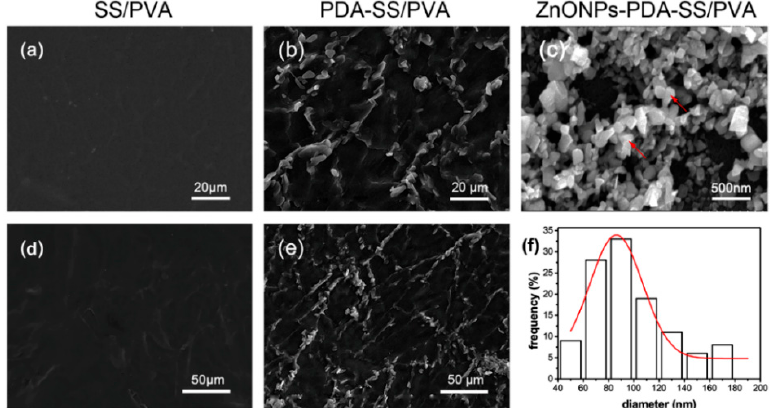
Figure 2. SEM of SS/PVA ( a , d ), PDA-SS/PVA ( b , e ) and ZnO NPs-PDA-SS/PVA films ( c ), respectively. The size distribution of ZnO NPs on the PDA-SS/PVA film ( f ).